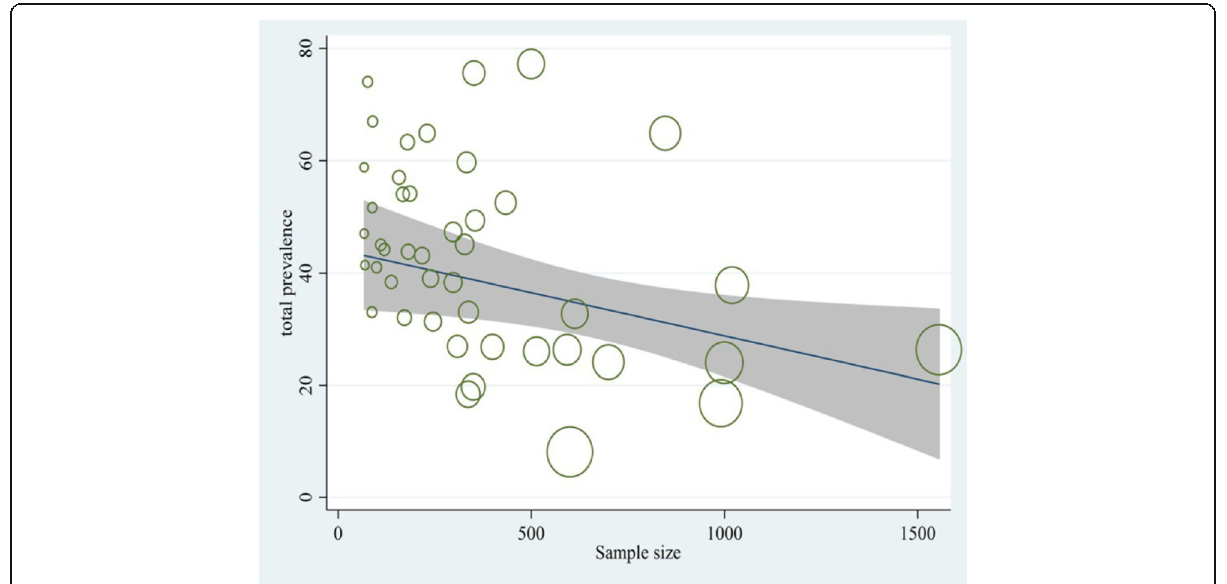
Fig. 4 Total prevalence of NSIs based on the sample size of selected studies by meta-regression analysis. Circles show the weight of the studies. The figure indicates a significant association between the prevalence of NSIs and sample size. The prevalence rate was reduced significantly with a rise in sample size